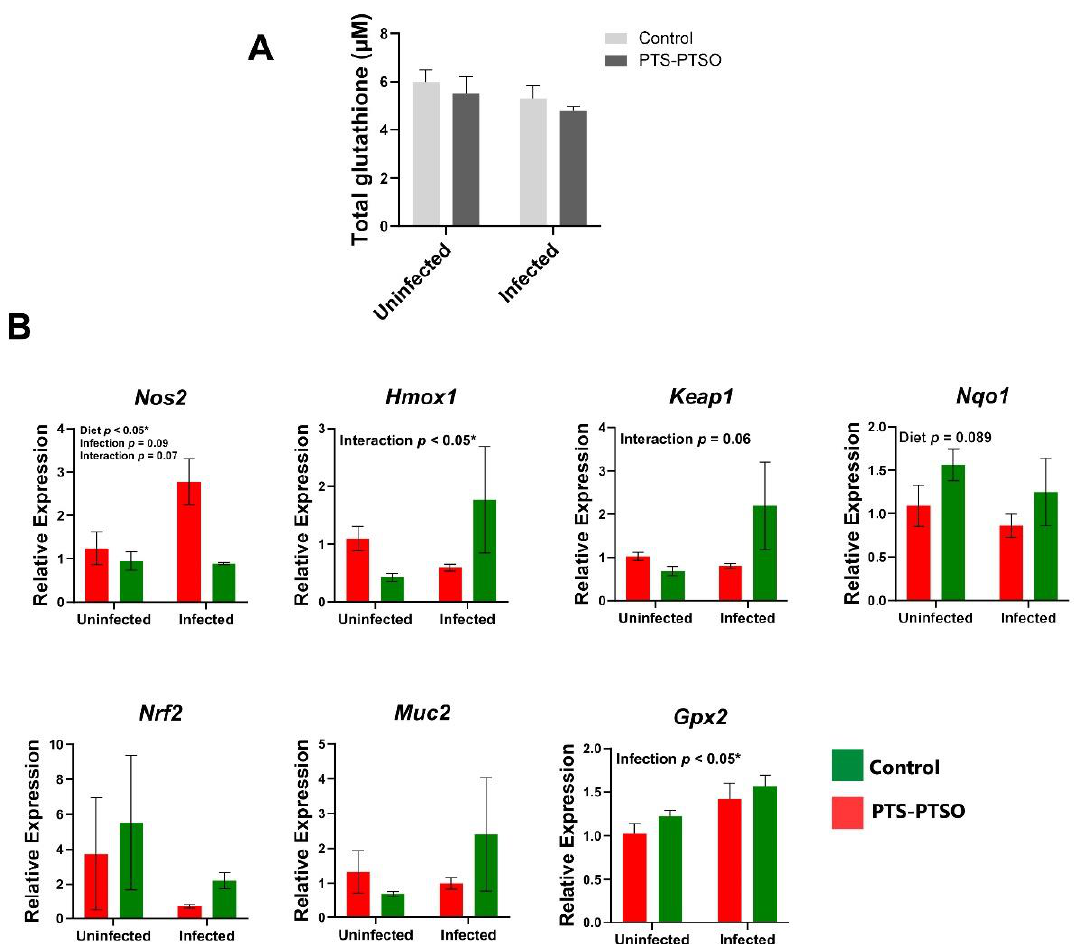
Figure 6. PTS-PTSO induces tendency of localized antioxidant response related to Nrf2 signaling against C. rodentium . ( A ) Total glutathione level of serum in naïve or C. rodentium infected mice treated with water or 1 mg/kg PTS-PTSO at 6 days p.i. ( B ) Relative gene expression of Nos2 , Gpx2 , Nrf2 , Nqo1 , Muc2 , Hmox1 and Keap1 . Data bars represent mean ± SEM. n = 6 per group. * p < 0.05.